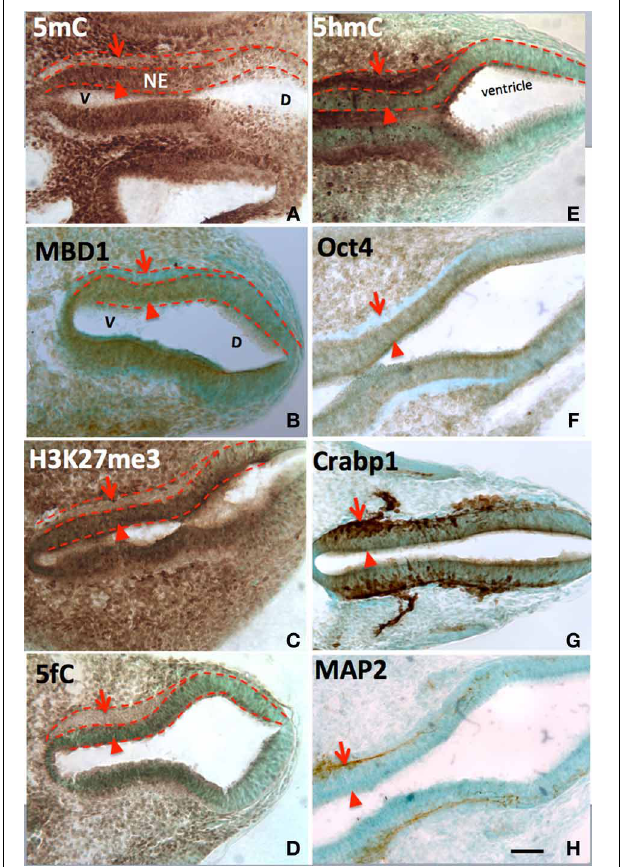
FIGURE 1 | The differential role of 5mC vs. 5hmC in the DNA methylation program is inferred by their association with phenotypic marks during the making of neural tube. At early neurulation (E10), a sequential escalation of 5mC and 5hmC occurred, where 5mC appeared first at neuroepithelial ( A , NE) layer (arrowheads) to prepare the differentiation, and faded as the NE cells differentiated and migrate away from ventricle ( A , arrows). At this time, the distribution of the DNA methylation binding protein, MBD1, has exactly the same pattern as that of 5mC (B) . Its function is depicted by the suppressive histone mark, H3K27me3, which distributed (C) similar to that of 5mC and MBD1. The demethylated metabolite 5fC also matched with 5mC. In contrast, the 5hmC appeared at differentiating neurons ( E , arrowheads) and continued to increase in differentiated neurons ( E , arrows). This program also occurred at ventro- (left) dorsal (right) gradation (A–H) where 5mC (A) preceded 5hmC (E) . The role of 5mC and 5hmC on neural tube cell differentiation is further depicted by the differentiation phenotypic markers in a spatially precise manner. The role of the 5mC is demonstrated by the appearance of the Oct4 in the NE layer ( F , arrowhead) and the loss of Oct4 in differentiated neurons ( F , arrow). The role of 5hmC is noted by the stage-wise neuronal marker Crabp1 (G) and MAP2 (H) distributed in a spatially correlated manner. V, ventral; D, dorsal. Scale bar: All = 100 μ m. Color scheme: Immunoreactive DAB, brown; counterstaining, methyl